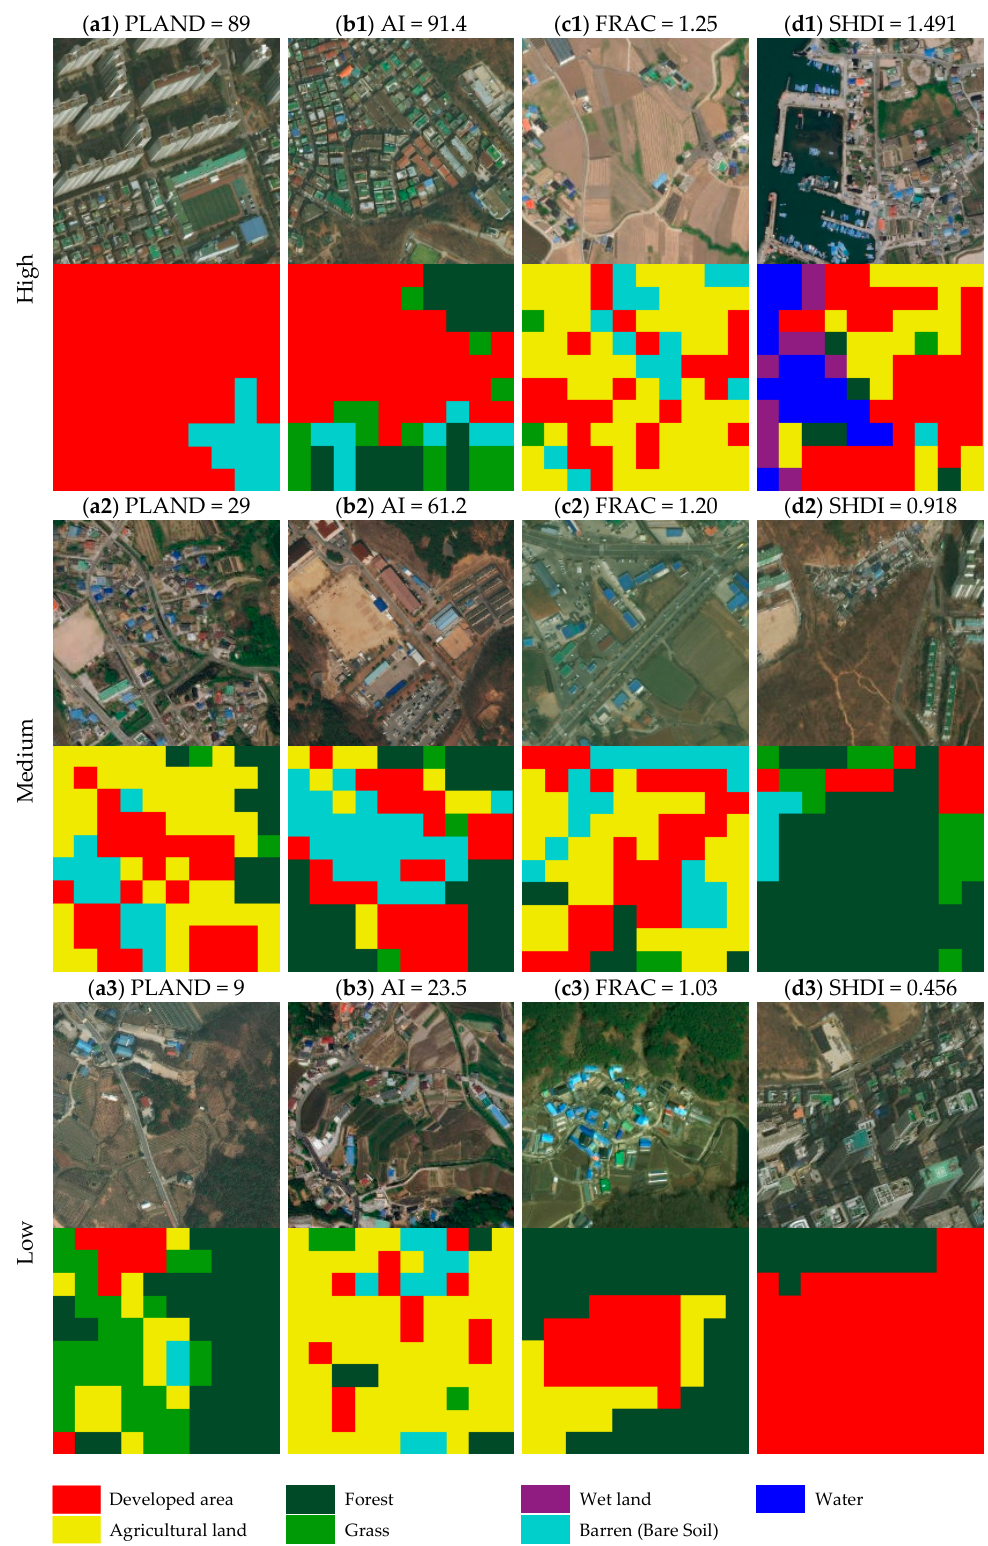
Figure 3. Examples of landscape metrics for developed area (PLAND, AI, FRAC, and SHDI).